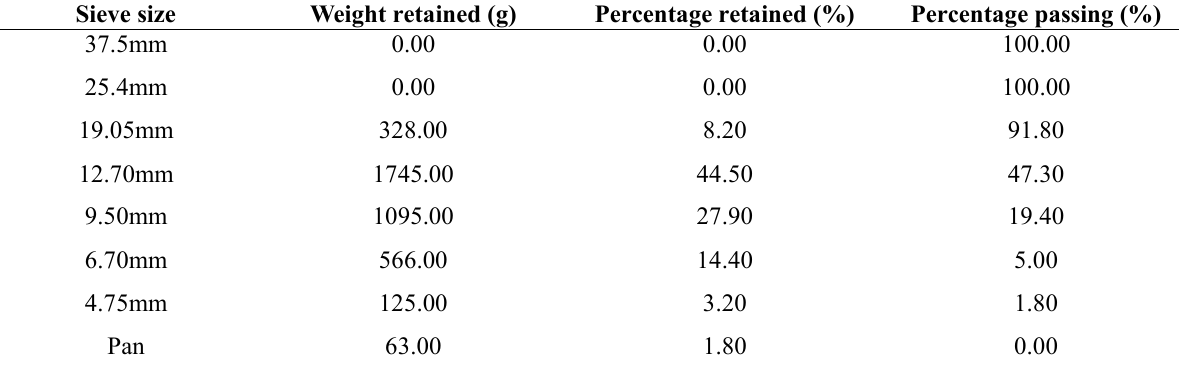
Sieve analysis for coarse aggregates (gravel). Sieve size Weight retained